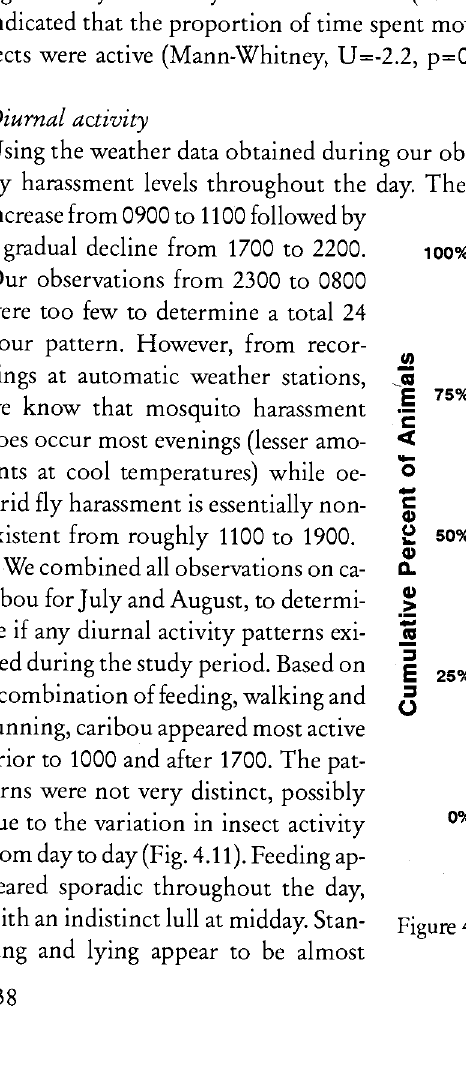
Figure 4.11. Diurnal pattern of various activities recorded for the Porcupine Caribou Herd in summer of 1984 and